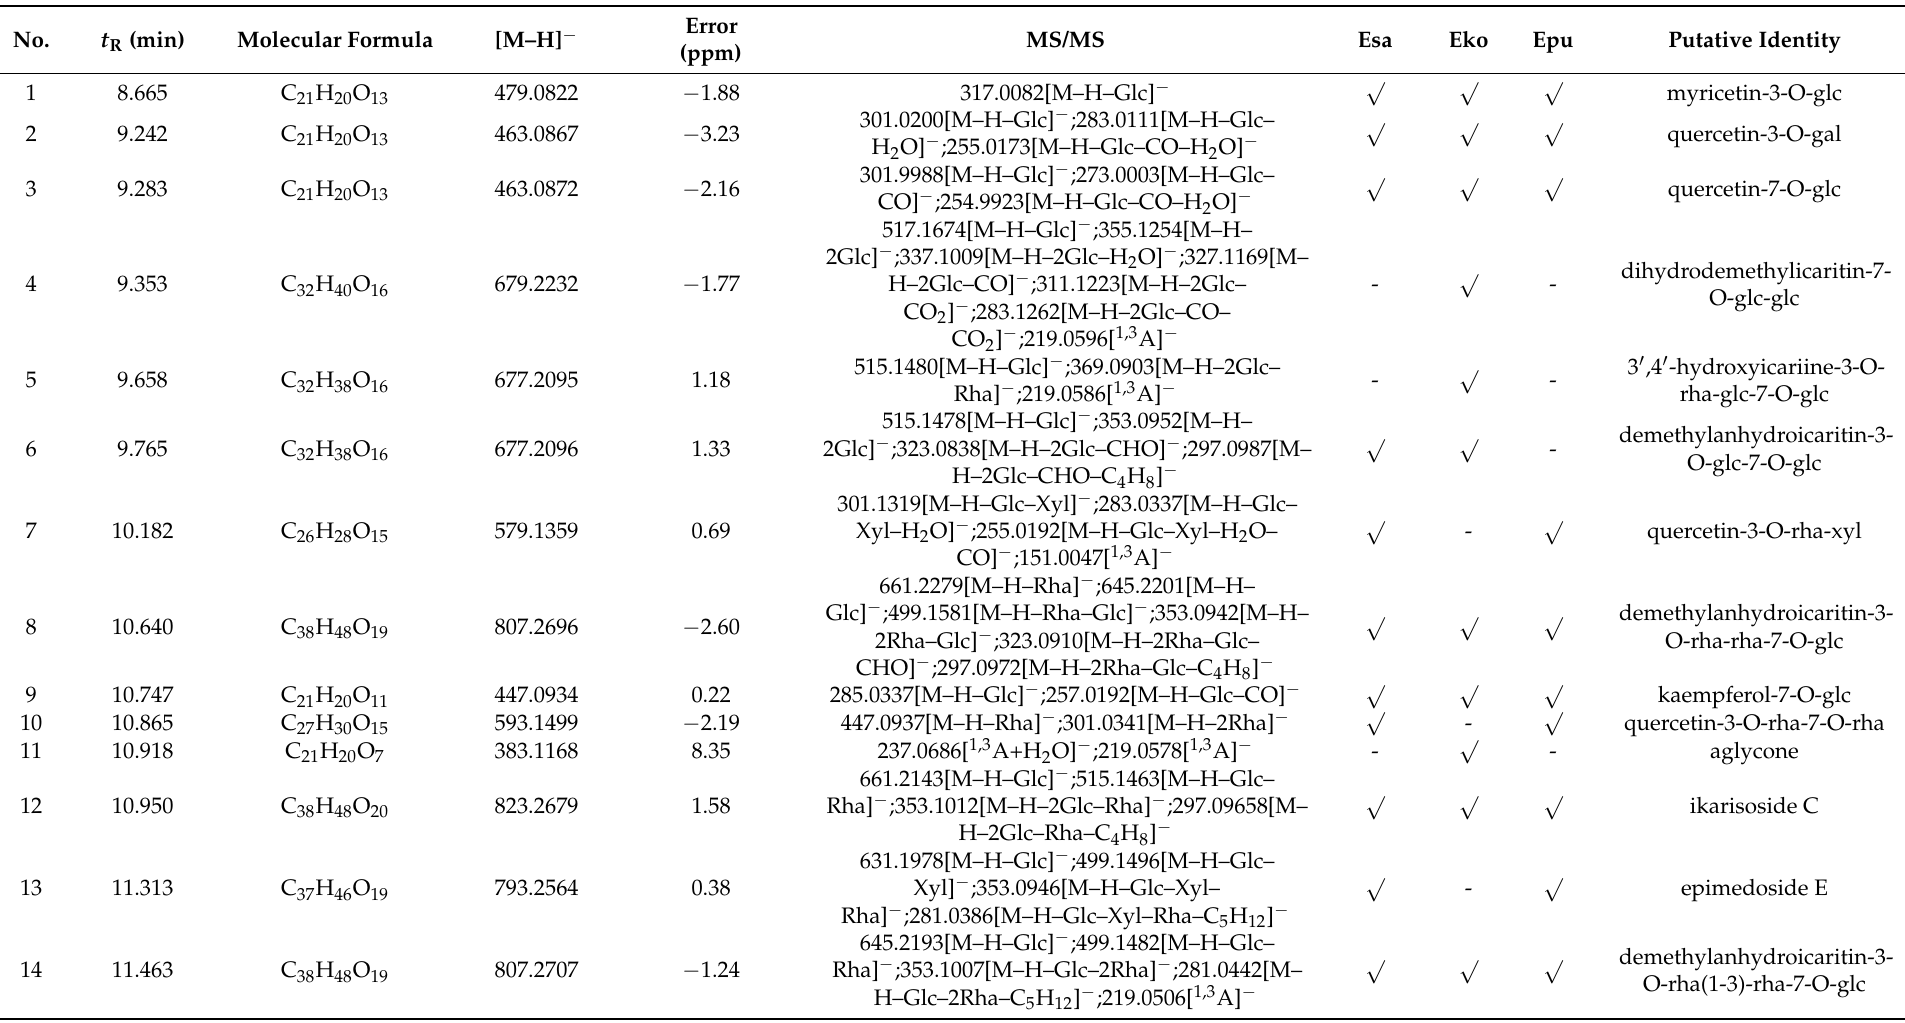
Table 1. Mass spectral data and plausible identities of the chemical compounds from Epimedium plants by OLE–UHPLC–IT-TOF-MS.